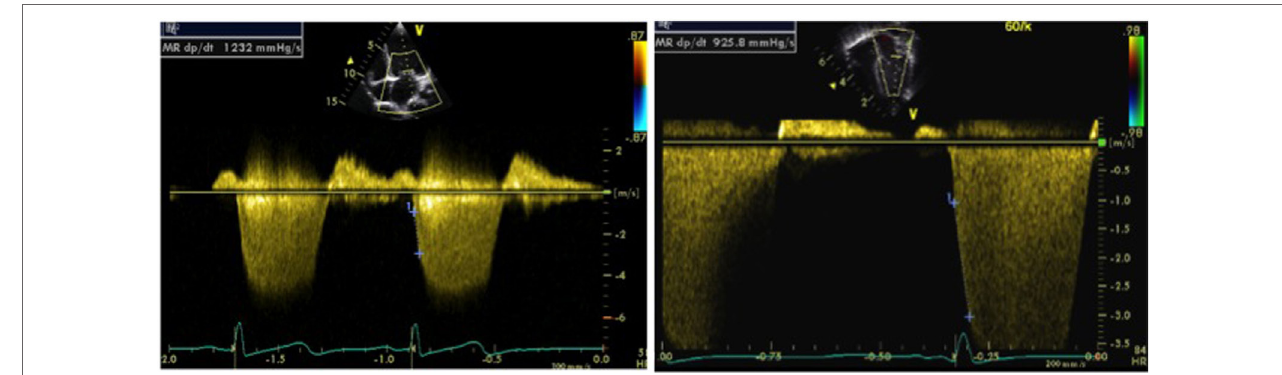
FigURe 4 | Doppler tracing from mitral regurgitation (MR) allowing measurement of the MR dP/dt max obtained between 1 and 3 m/s, on a normal patient (left image) and on a patient with left ventricular dysfunction (right image). An MR dP/dt max < 500 mmHg/s is indicative of left ventricular systolic dysfunction. The same can be applied to tricuspid regurgitation (TR dP/dt max) but has to be measured between 1 and 2